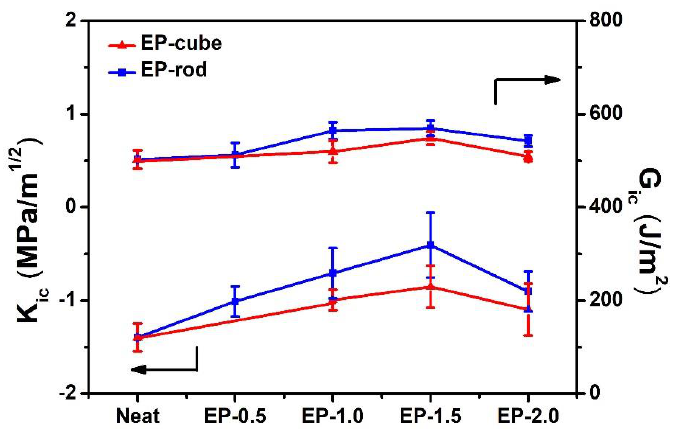
Figure 4. Fracture toughness ( K ic ) and fracture energy ( G ic ) of neat epoxy and its epoxy composites with different content of CaCO 3 .